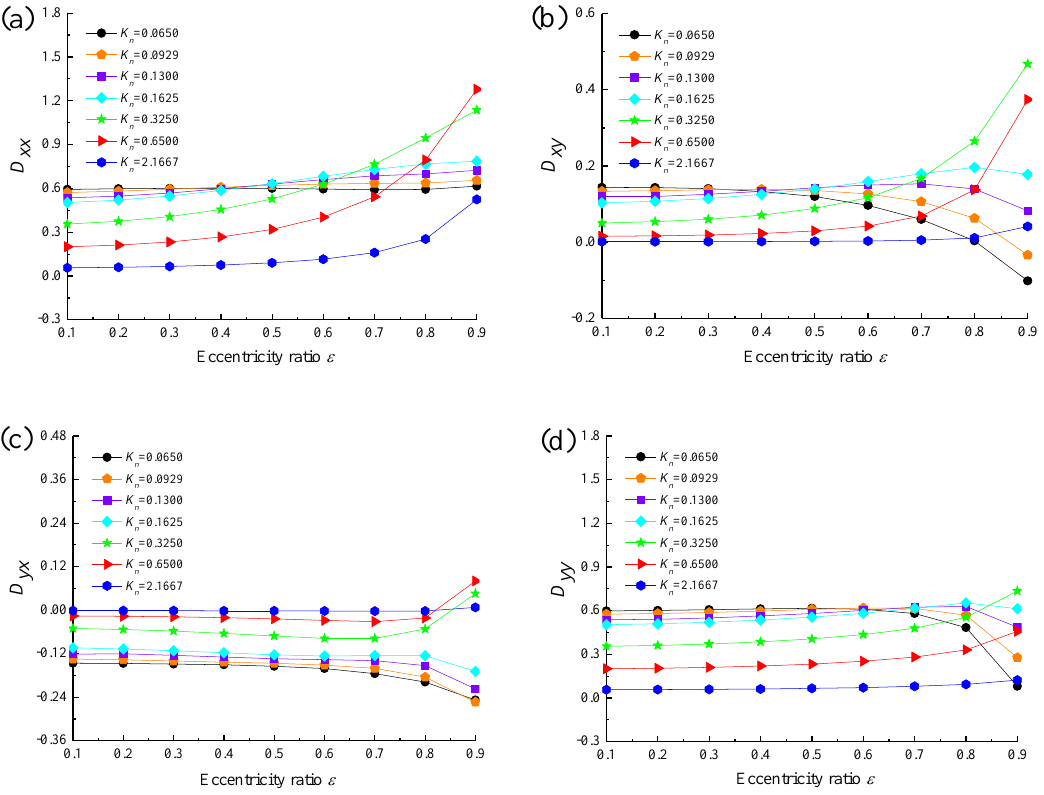
Figure 12. Dynamic damping coefficients of Boltzmann model plotted as function of eccentricity ratio for various Knudsen numbers. ( a ) D xx vs. ε ; ( b ) D xy vs. ε ; ( c ) D yx vs. ε ; ( d ) D yy vs. ε.